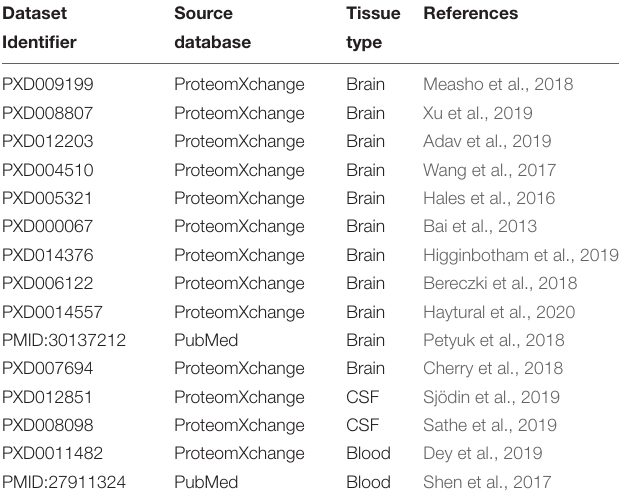
TABLE 1 | List of datasets used in the